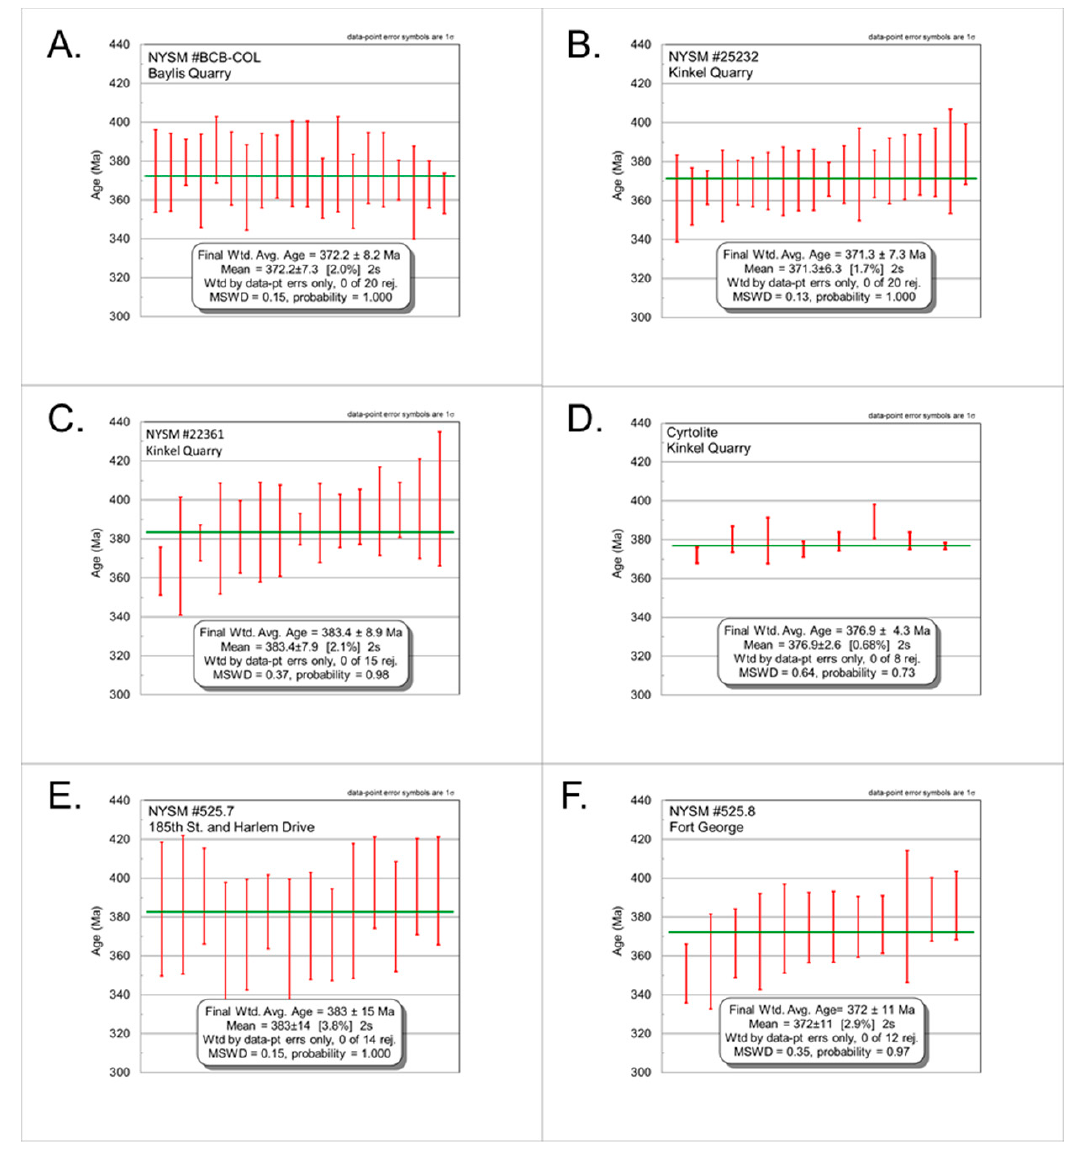
Figure 4. Weighted averages for columbite samples and cyrtolite analyzed during this study: ( A ) Baylis (NYSM #BCB-COL); ( B ) Kinkel (NYSM #25232); ( C ) Kinkel (NYSM #22361); ( D ) Kinkel (Cyrtolite); ( E ) Harlem River Drive (NYSM #525.7); and ( F ) Fort George (NYSM #525.8). All were analyzed by LA-MC-ICP-MS at University of Arizona in Tucson.